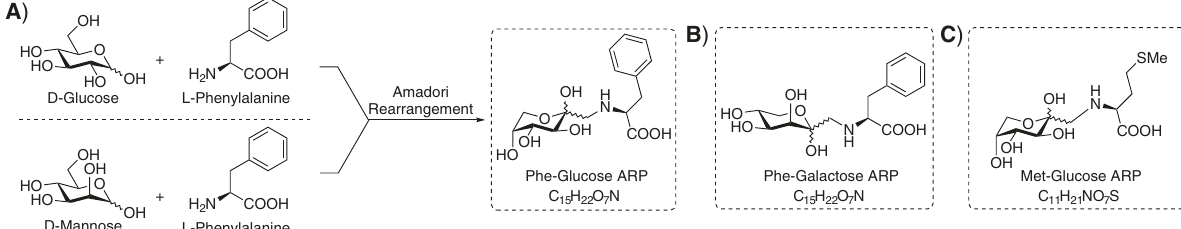
Fig. 2 Chemical structures of the amino acid-hexose standards determined by NMR spectroscopy. a Reaction of D -glucose and D -mannose with L -phenylalanine results in the ARP product Phe-glucose ARP. b Structure of the Phe-galactose ARP reaction product. c Structure of the Met-glucose ARP reaction product. All structures are found to be Amadori rearrangement products